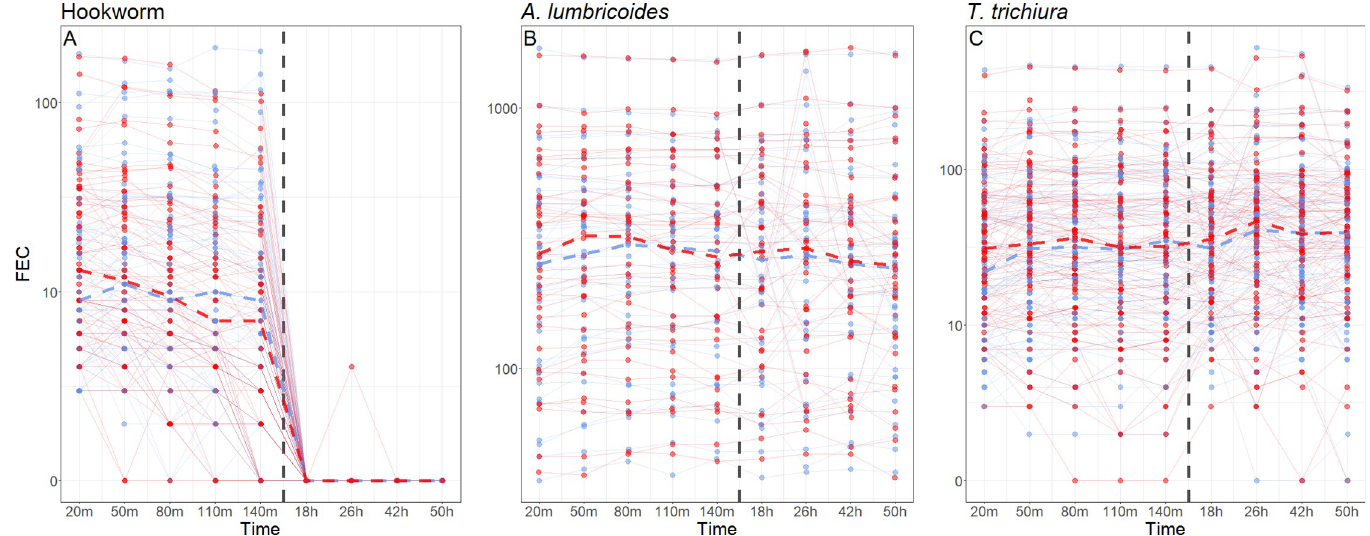
Fig 4. Kato-Katz storing experiment: Absolute median fecal egg counts (FEC) change over time for (A) hookworm (n = 67 for room temperature, n = 62 for refrigerator), (B) A . lumbricoides (n = 38) and (C) T . trichiura (n = 85). Blue = refrigerator temperature, red = room temperature, A . lumbricoides = Ascaris lumbricoides , T . trichiura = Trichuris trichiura .